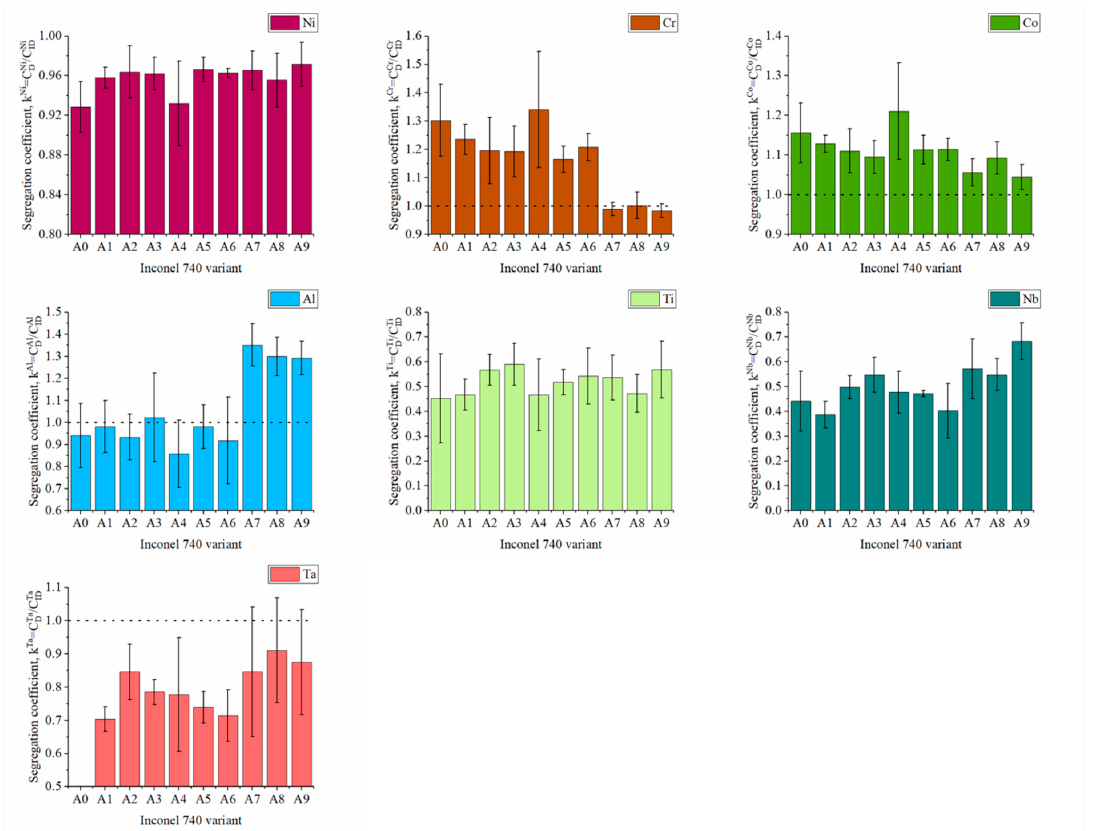
Figure 6. Segregation coefficient k i of alloying elements in the fabricated castings.